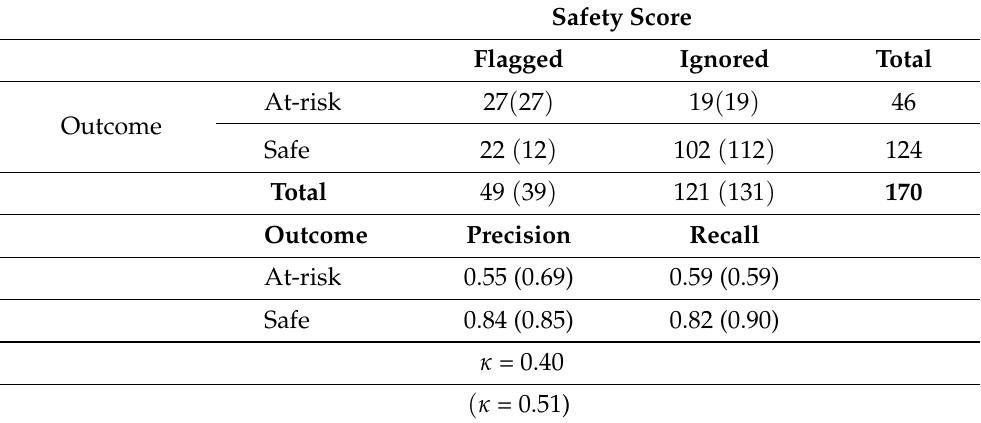
Table 18. Confusion matrix and summary of BM test set